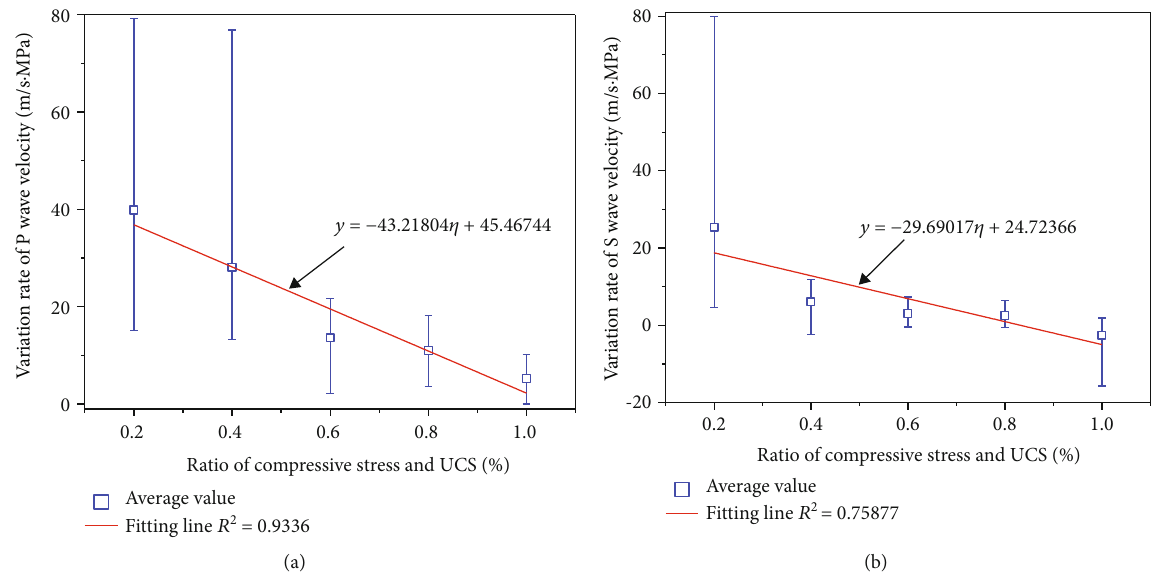
Figure 10: Variation rate of P wave and S wave velocities during the loading